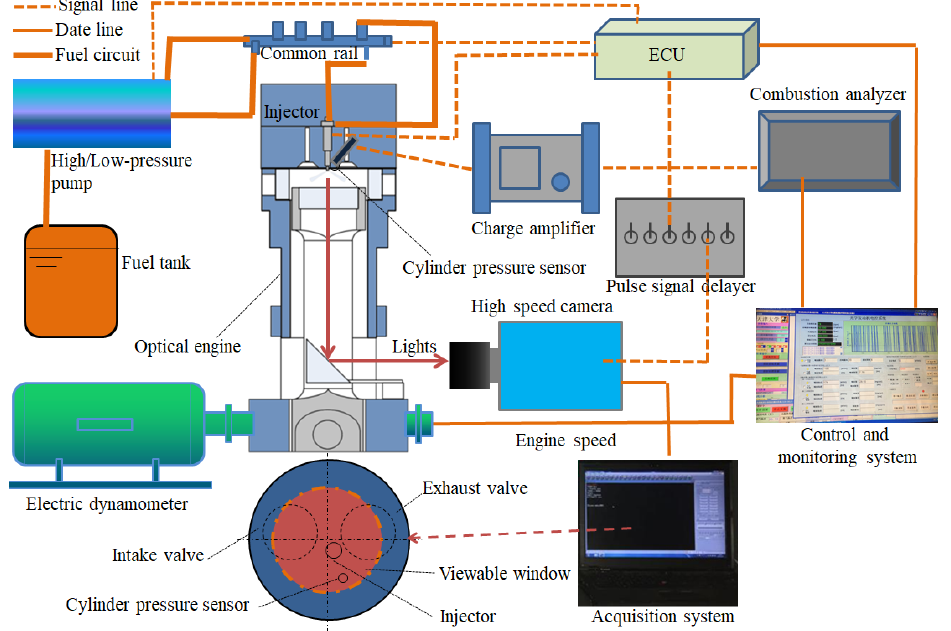
Figure 2. The experimental scheme of the optical engine system.